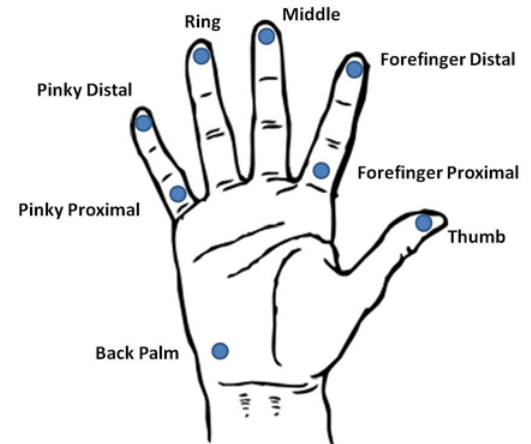
Fig. 4. Semmes-Weinstein hand test locations.